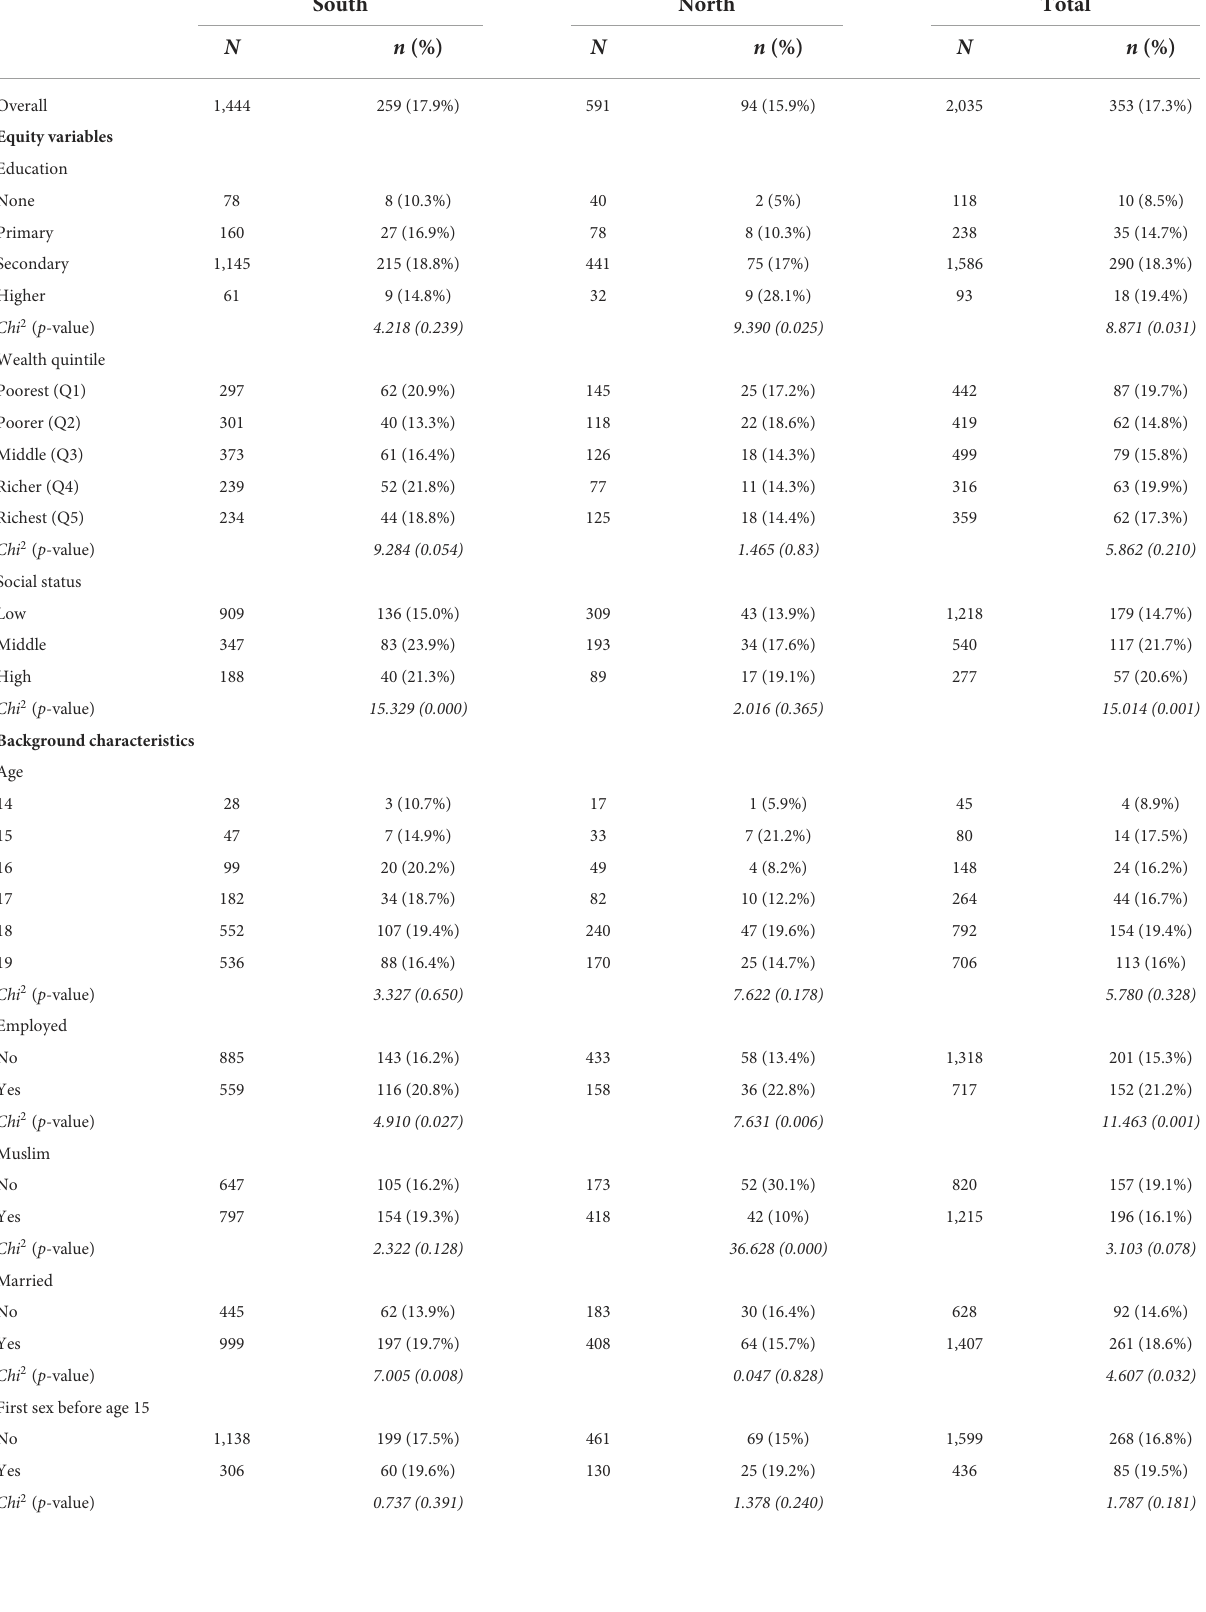
TABLE 2 Bivariate association between modern contraceptive use, equity variables, and background characteristics of adolescent girls in selected urban slums in Nigeria. South